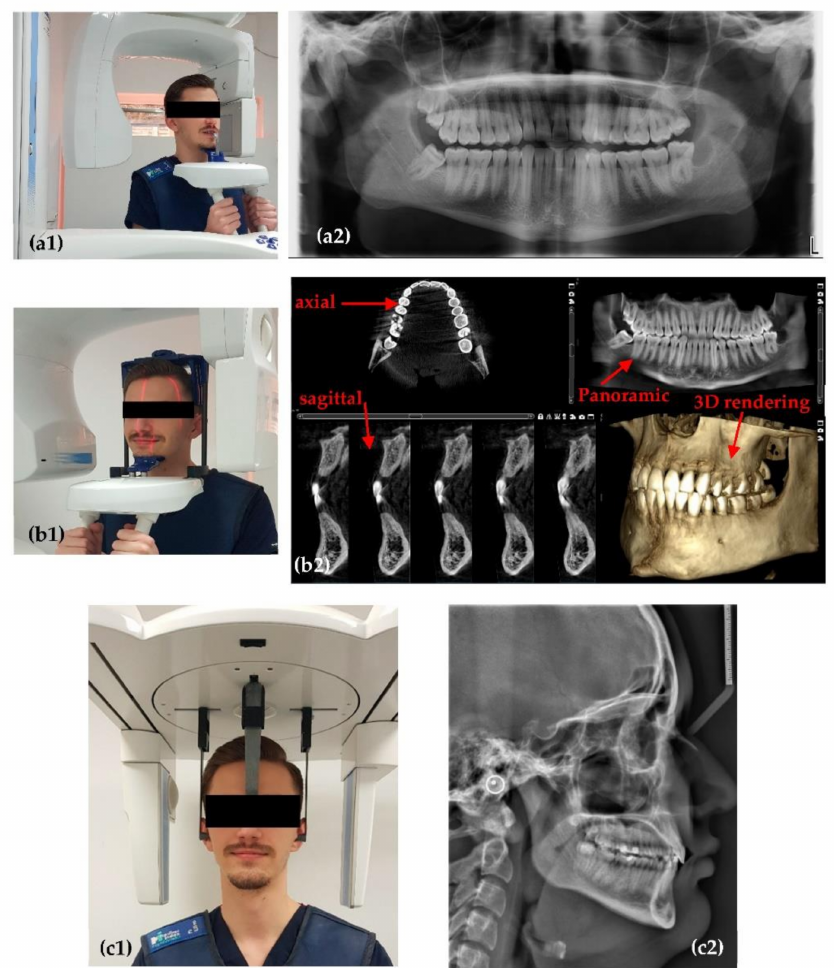
Figure 1. Example of the Planmeca setup for ( a1 ) panoramic, ( b1 ) 3D CBCT, and ( c1 ) cephalometric investigations (of a healthy member of the staff). Obtained images: ( a2 ) panoramic; ( b2 ) 3D CBCT images, with axial, sagittal, and panoramic views, as well as a 3D reconstruction; ( c2 )